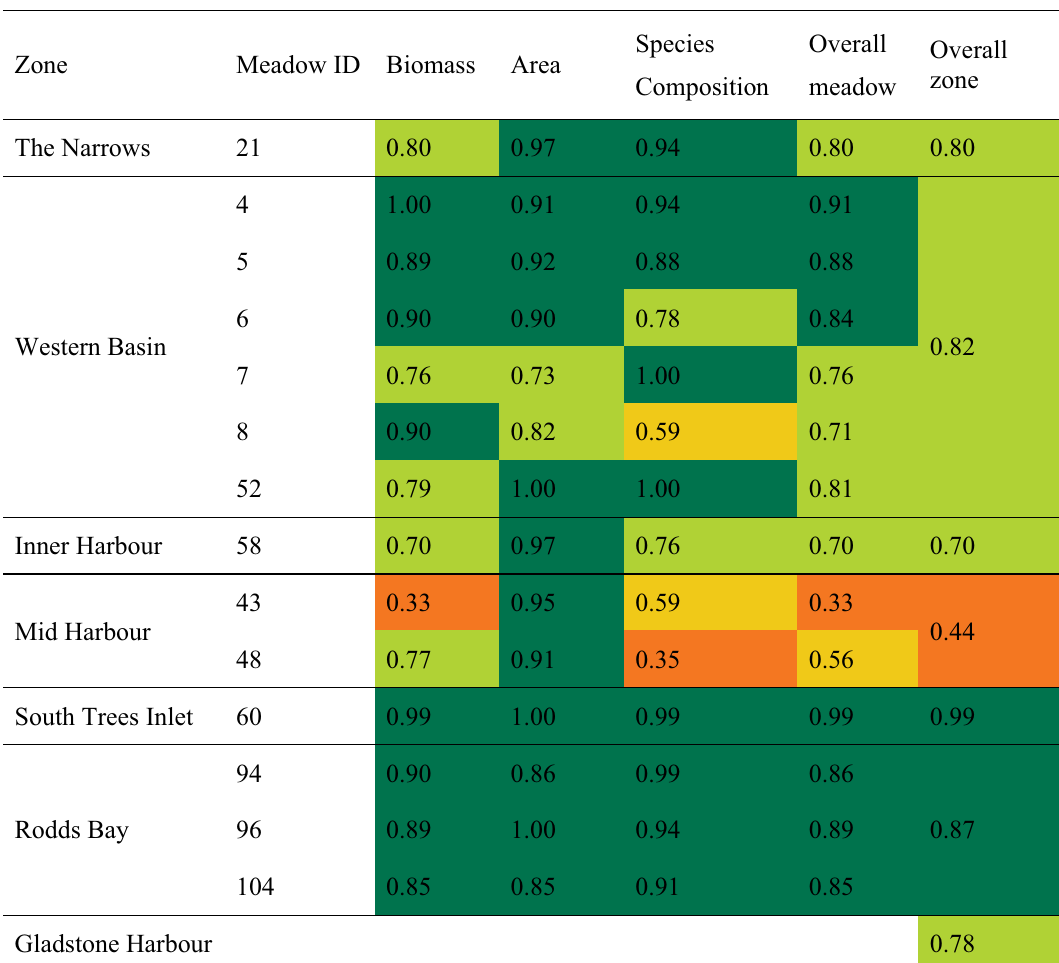
Table 4. Grades and scores for seagrass indicators (biomass, area and species composition), overall meadow, zone, and Gladstone Harbour scores for the 2020 report card (2019 field survey). Cells are coloured according to grade (see Table 1 for grading scale and colour legend and Fig. 5 for map of